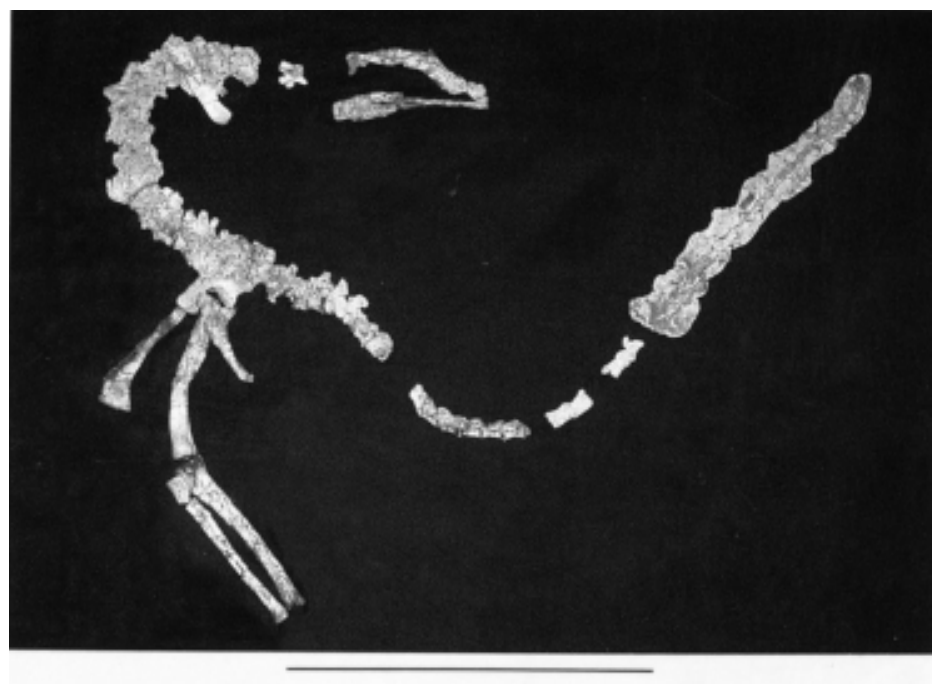
Fig. 12 – Preserved skeleton of Staurikosaurus pricei , a primitive theropod from the Santa Maria Formation (Triassic). Scale bar: 500